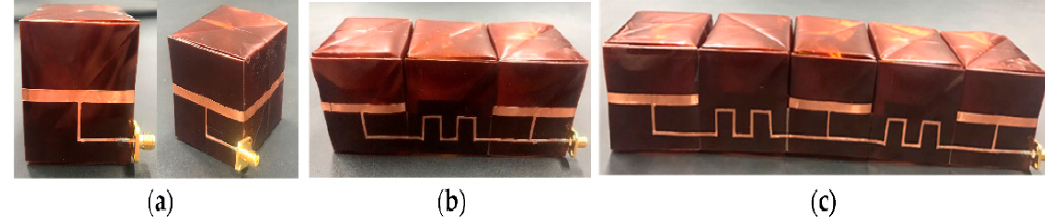
Figure 5. Fabricated proposed antenna array based on magic cube origami for: ( a ) single antenna and cube ( b ) two antennas and ( c ) three antennas [95].